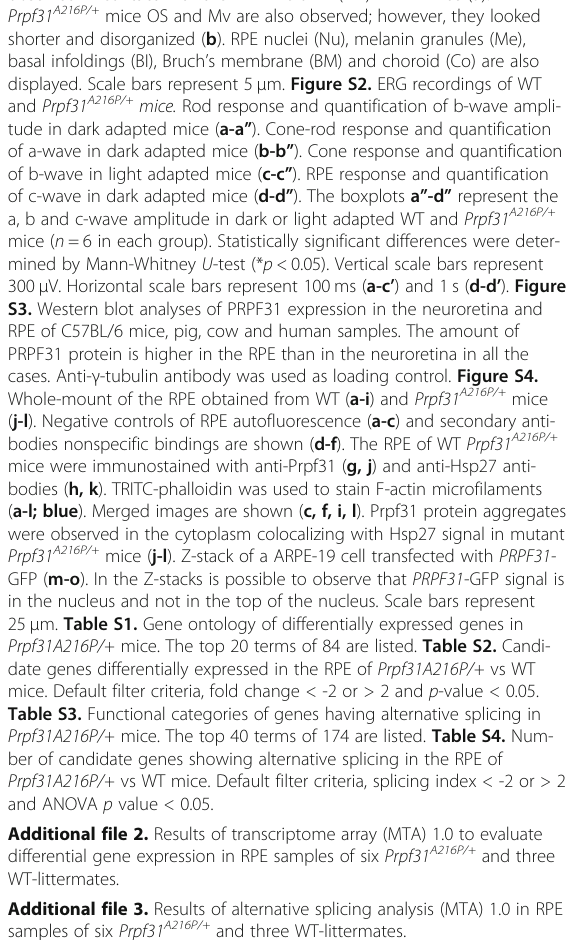
Additional file 1: Figure S1. TEM images of RPE of 8-month-old WT ( a ) and Prpf31 A216P/+ mice ( b ). Photoreceptor outer segments (OS) were